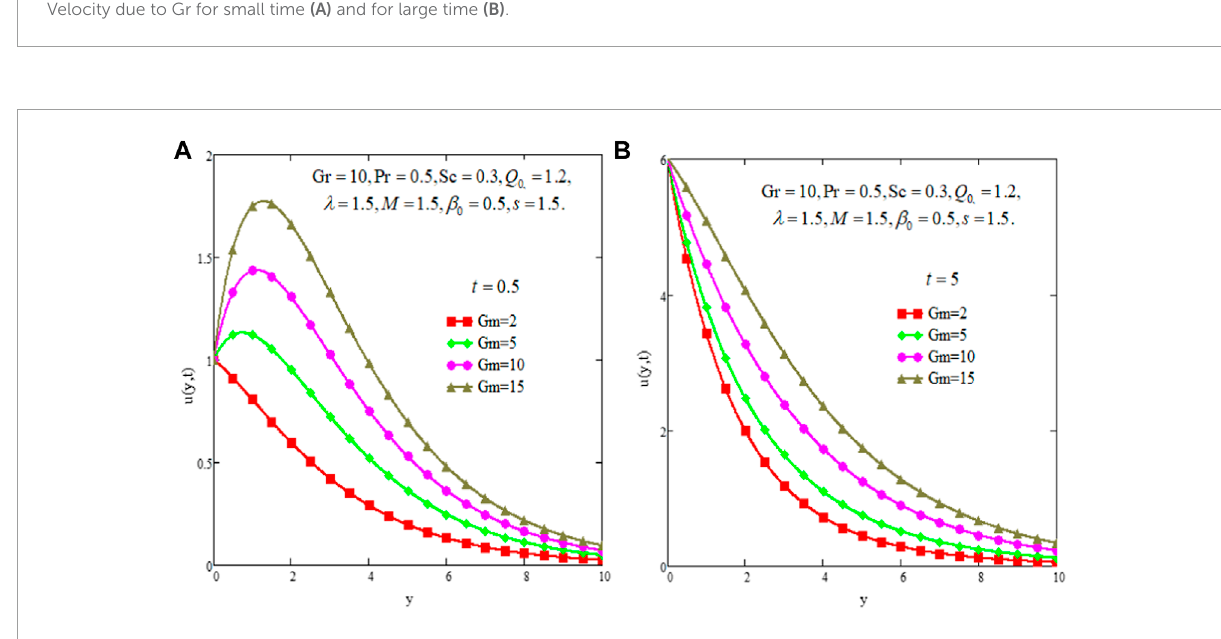
FIGURE 3 Velocity due to Gm for Small time (A) and for large time (B)